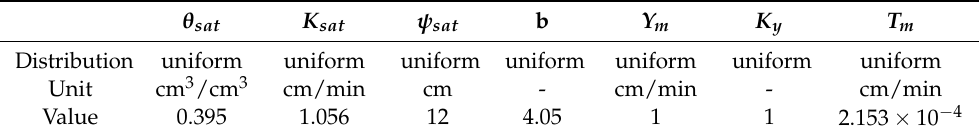
Table 2. Soil hydraulic parameters used in the case study. θ sat K sat ψ sat b Y m K y T